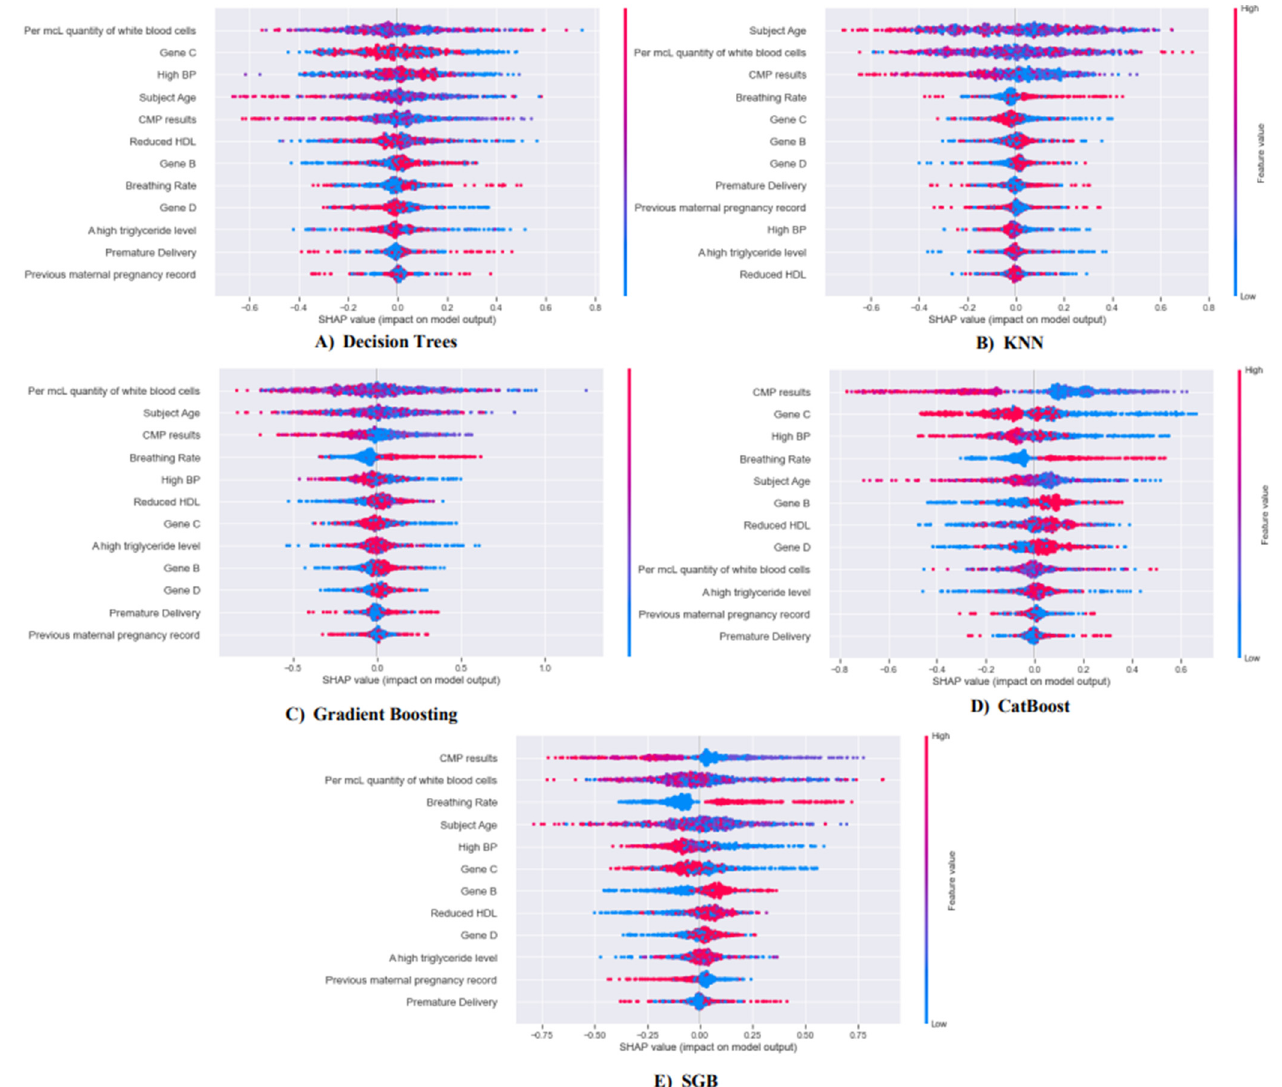
Figure 4. The most informative metabolic indicators using PSO, FA, and ANT optimizers. Blue dots represent a low contribution to the predictive model, whereas red dots represent high impact. ( A ) Shows quantity of white blood cells as the most important feature according to DTs. ( B ) Shows the subject age as the most important feature according to KNNs. ( C ) Shows quantity of white blood cells as the most important feature by GB. ( D , E ) Show the comprehensive metabolic panel test as the most informative feature according to CatBoost and SGB.